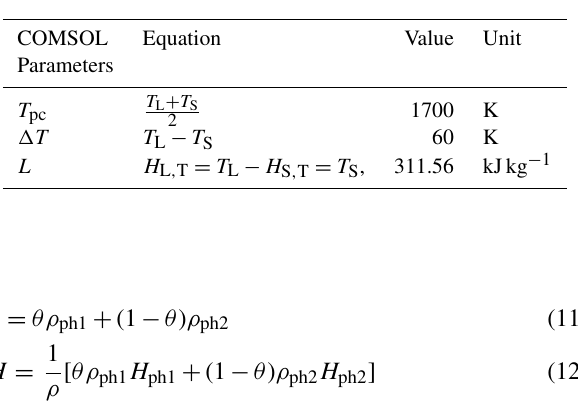
Table 1. Parameters and values used within the COMSOL Multiphysics ®